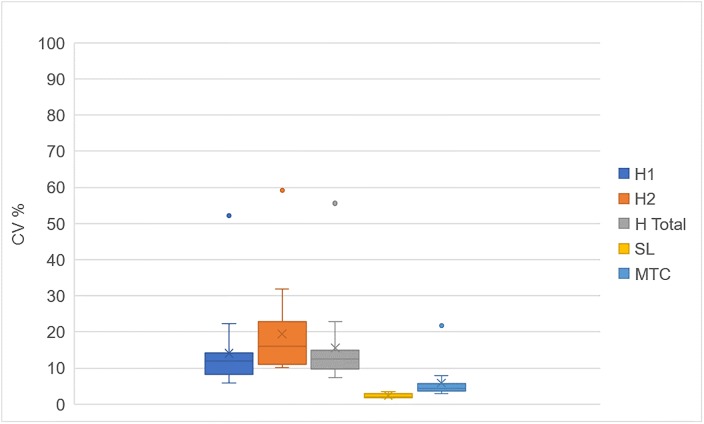
Greater CV for H1, H2 and HT for all participants compared to SL and MTC at 1.4 m/s.